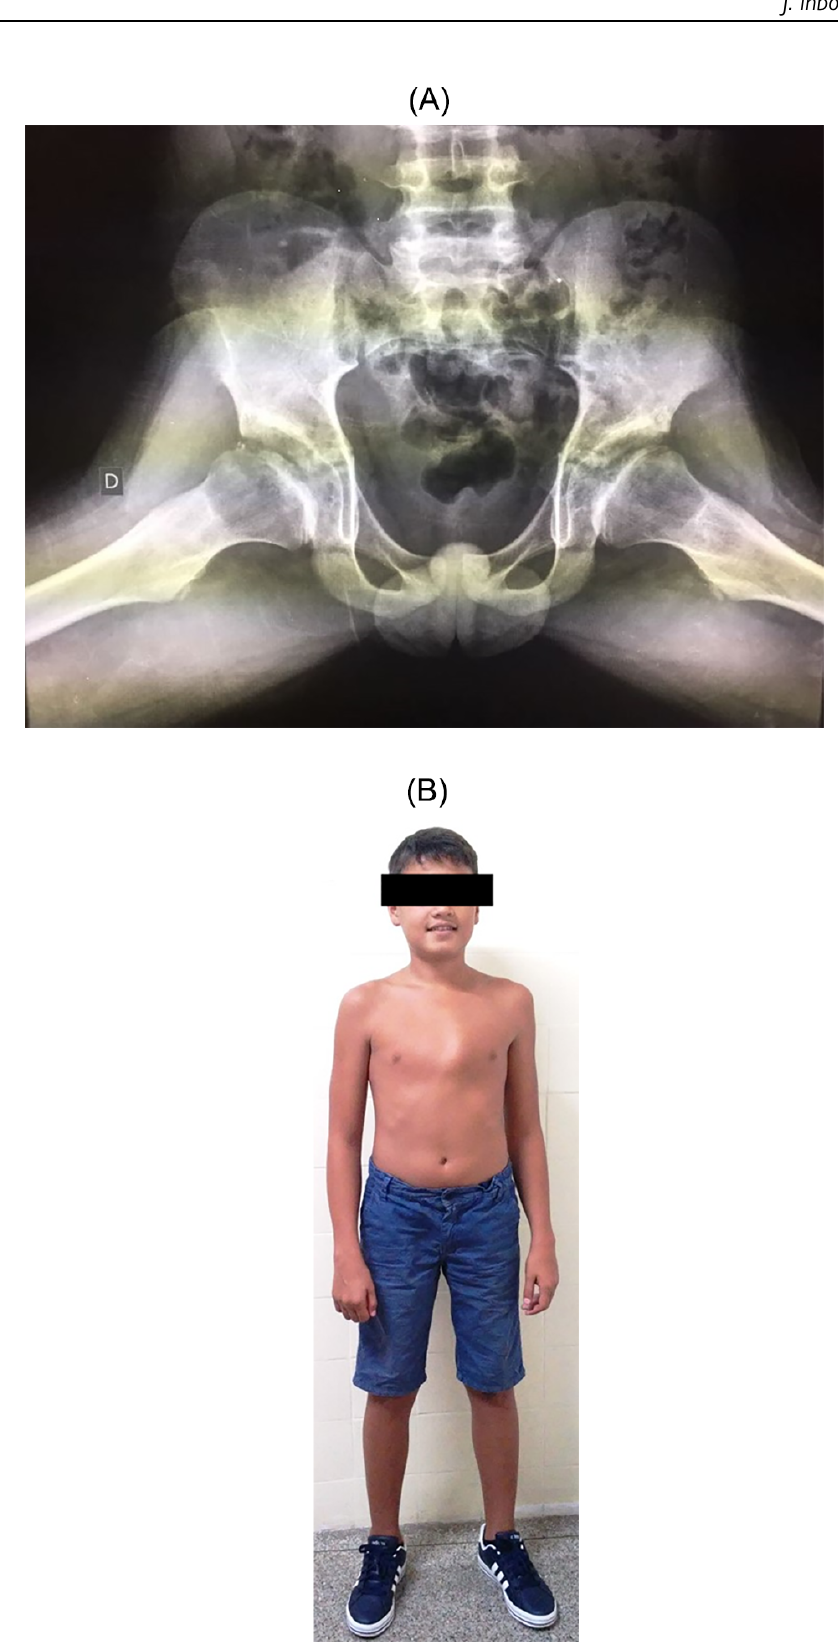
Figure 2. (A) Hip radiography of a male 14-year-old MPS IVA patient (patient #9) showing shallow acetabular cavities, irregular bilaterally contours, widening of the joint space, reduction of V-shaped with increased density and irregularity of the contours of the femoral heads bilaterally and flattened in the loading zones; (B) Pectus carinatum in the same